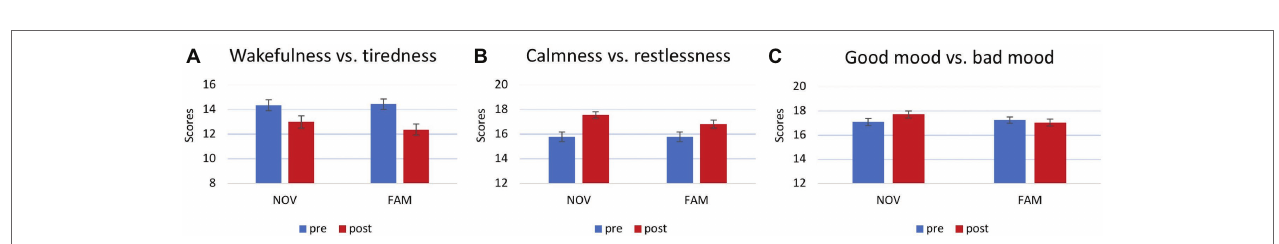
FIGURE 5 | Mental state ratings after movie presentation. (A) Main effect for wakefulness vs. tiredness. Higher values represent wakefulness, lower values tiredness. (B) Main effect for calmness vs. restlessness. Higher values represent calmness, lower values restlessness. (C) Interaction between good mood vs. bad mood and group. Higher values represent good mood, lower values bad mood. Increase of good mood in the NOV group, no change in the FAM group.